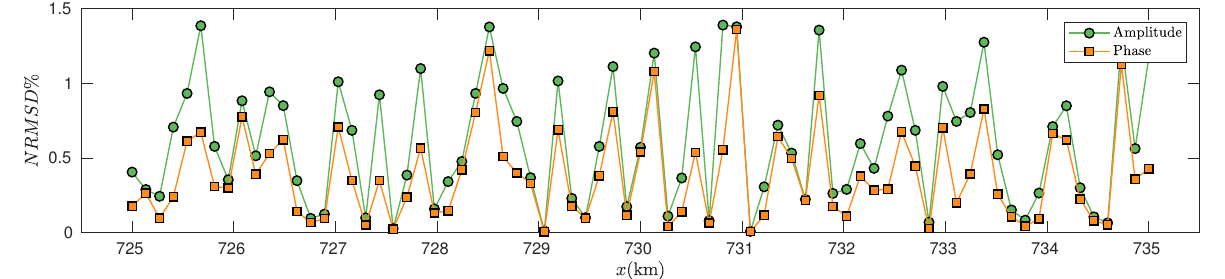
Figure 5. NRMSD for amplitude | E x | and phase Φ x depicted in Figure 4. Non-homogeneous setup of 3D-VTI-B model is compared.